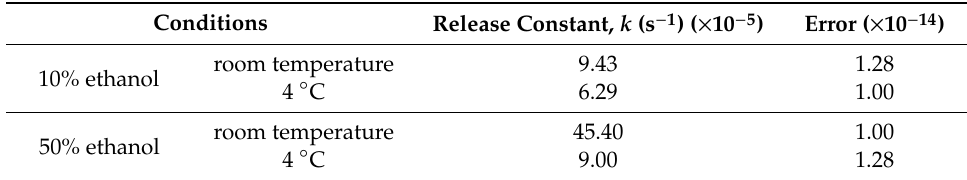
Table 6. Diffusion coefficient of isopropyl palmitate determined using the late-time approximation of Fick’s second law of diffusion.